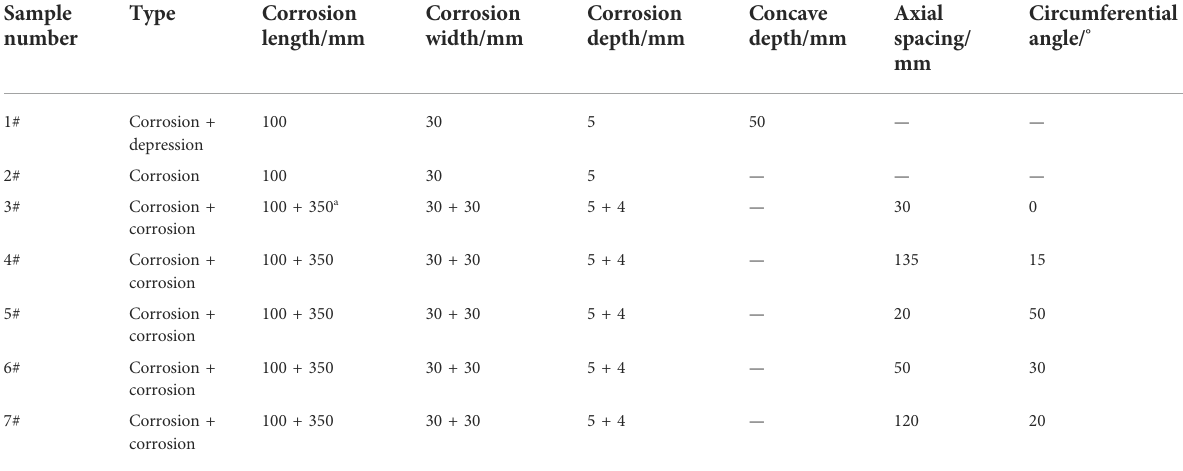
TABLE 1 The list of the pipe samples with different corrosion and concave defects.